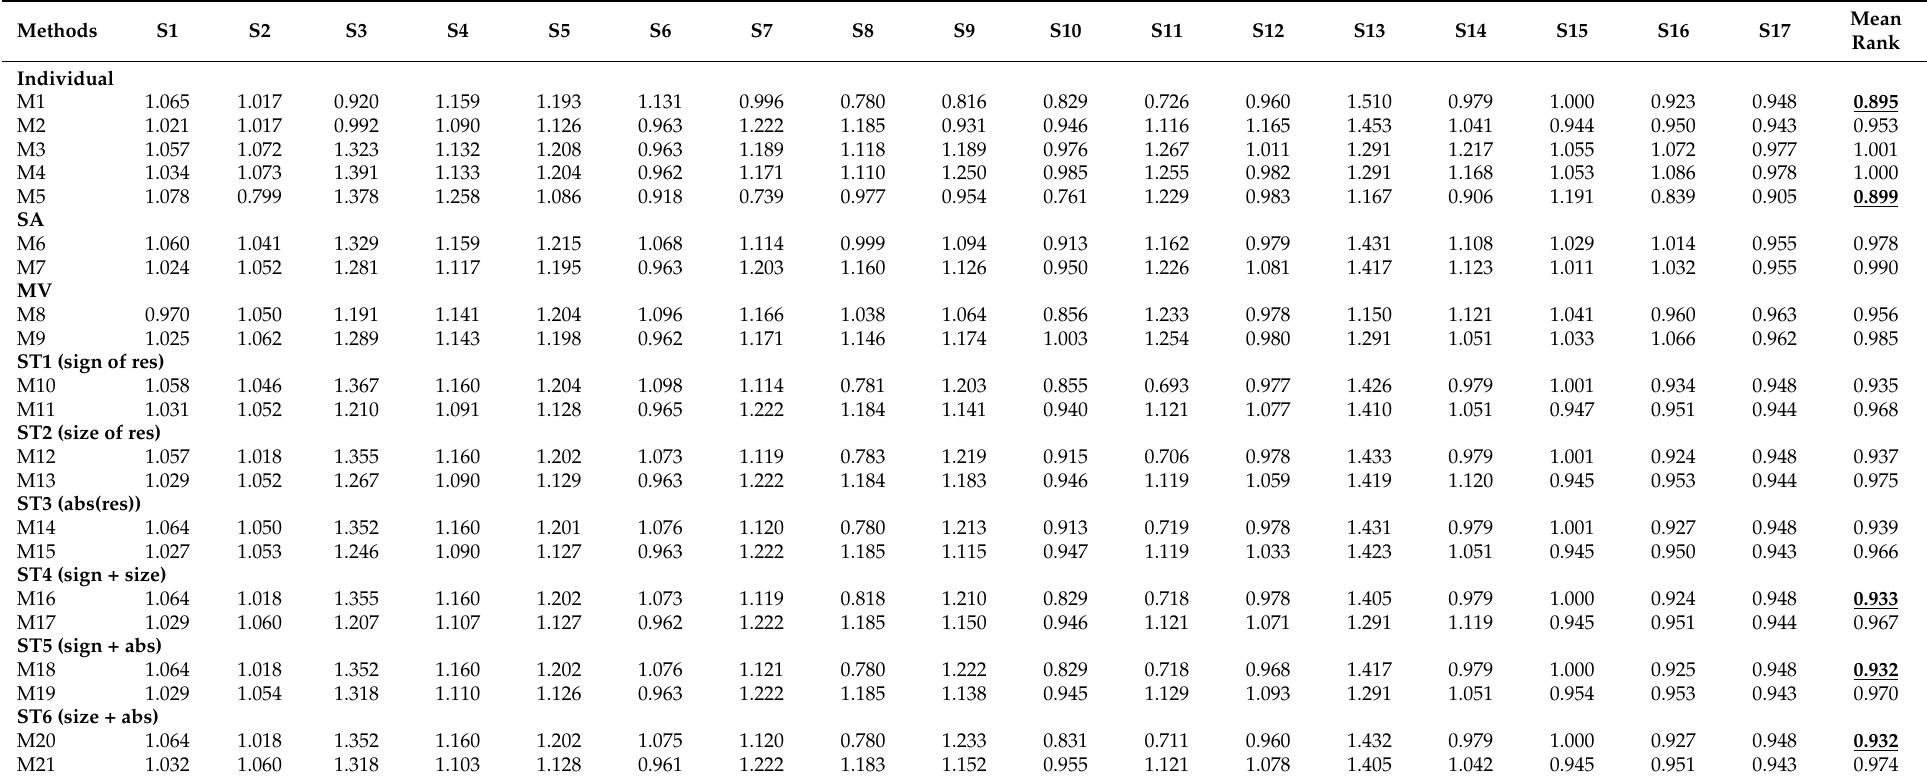
Table 14. MAAPE for out-of-sample in tourism demand volatility